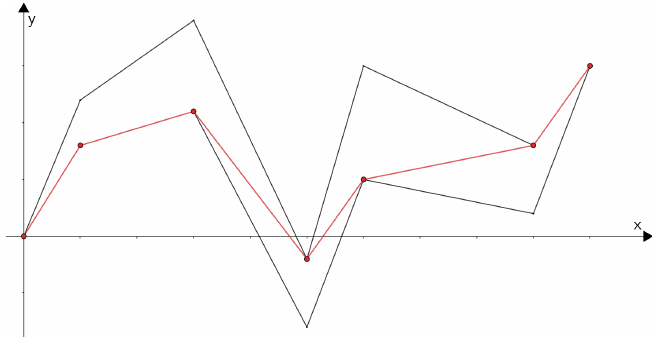
Figure 6. Taut string (red) in the